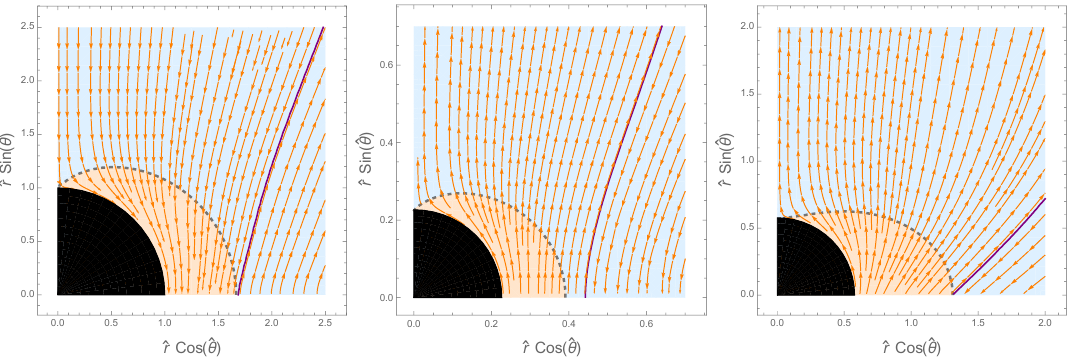
Figure 6 . Polar vector plots of the Poynting flux stream lines for the NHEK, AdS-NHEK and SE- NHEK solution, in the (ˆ r, ˆ θ ) plane of (AdS/SE-)Kerr. Only the first quadrant is shown. In NHEK and AdS-NHEK, the location where the flux changes sign (purple line) corresponds at the equator to the start of the Kerr ‘ergoregion’ as determined by the NHEK observer, which is the orange shaded region bounded by the gray dashed line. The region behind the horizon is shaded in